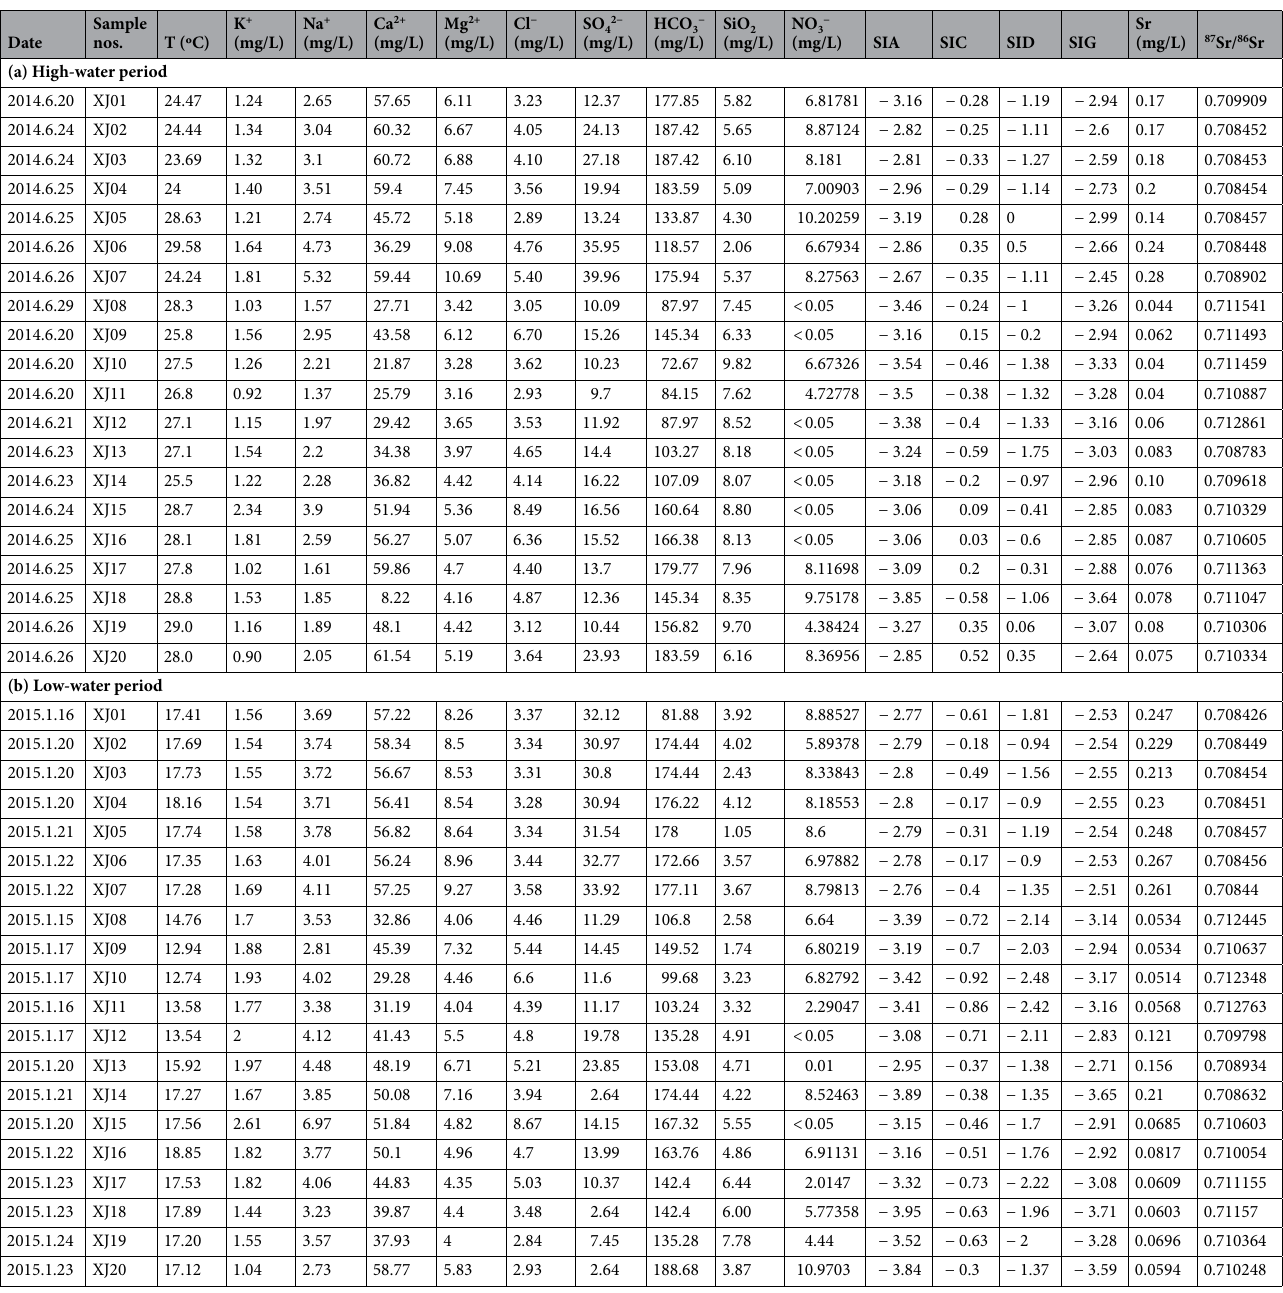
Table 7. The main ion concentrations and saturation indices in the study area for the (a) high- and (b) low- water